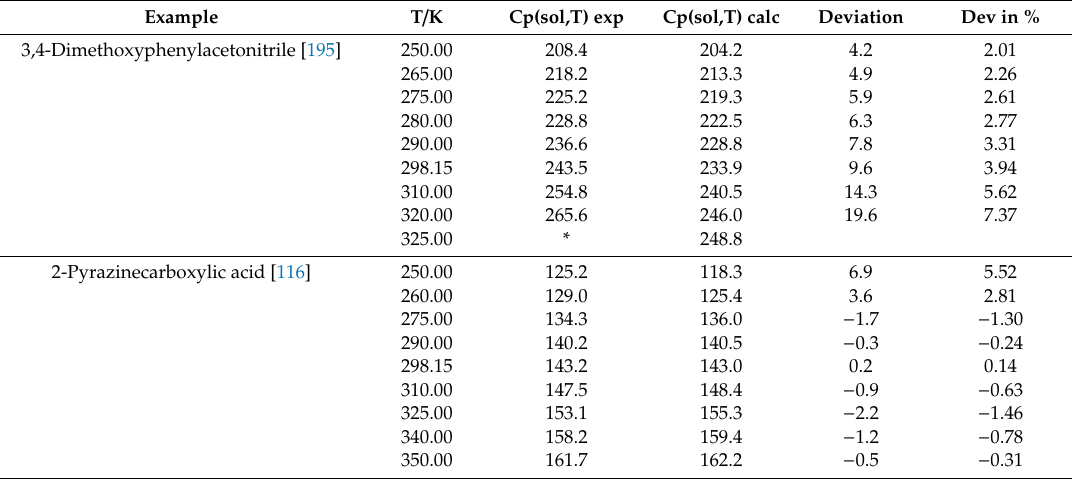
Table 20. Experimental and calculated solid heat capacities of two compound samples at various temperatures in J / mol / K. (Calculations based on parameters of Tables 17 and 18, respectively). Example T / K Cp(sol,T) exp Cp(sol,T) calc Deviation Dev in % 3,4-Dimethoxyphenylacetonitrile [195]